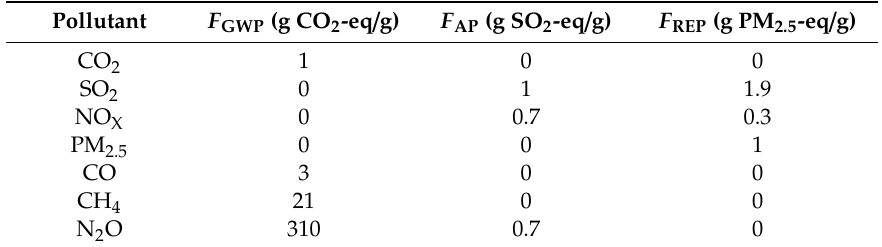
Table 3. Conversion factors between various pollutant emissions for globe warming potential (GWP), acidification potential (AP), and respiratory e ff ects potential